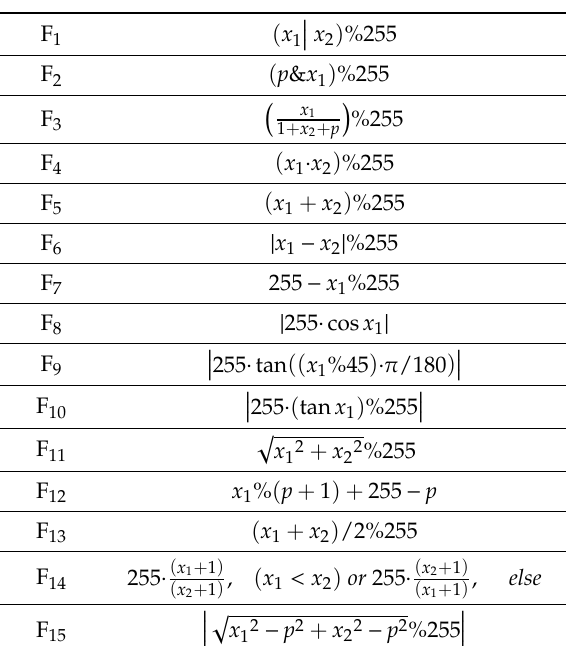
Table 1. CGP aesthetic fitness